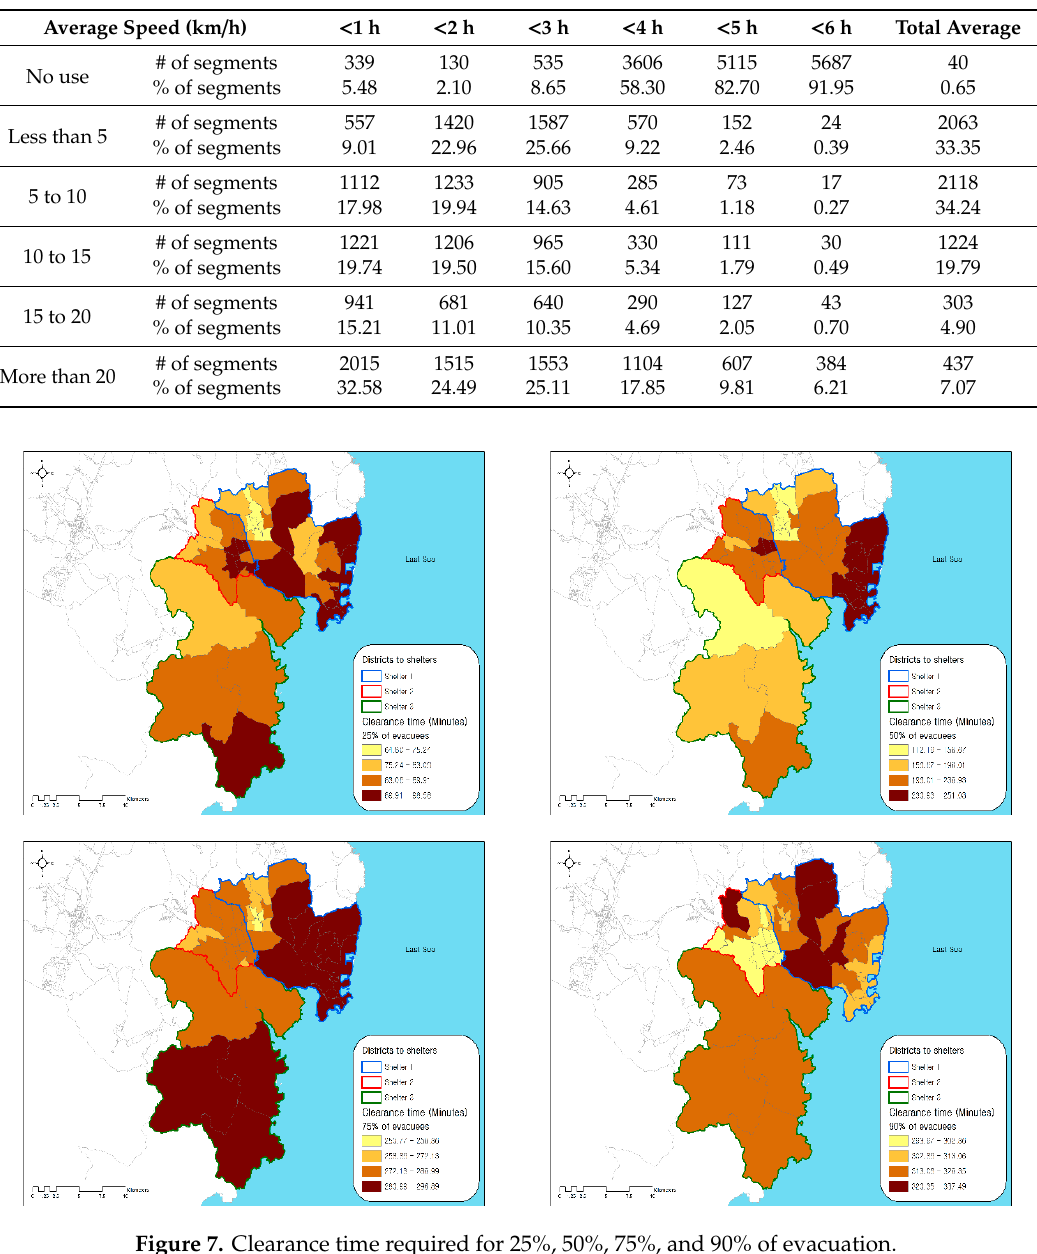
Figure 7. Clearance time required for 25%, 50%, 75%, and 90% of evacuation. Table 4. Average speed of vehicles from 1 to 6 h after the occurrence of accidents.